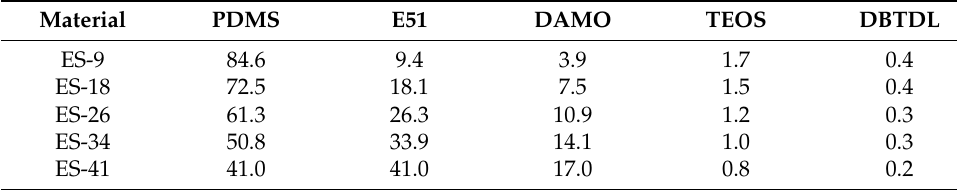
Table 1. The formulation of the epoxy-modified silicone tie-paint